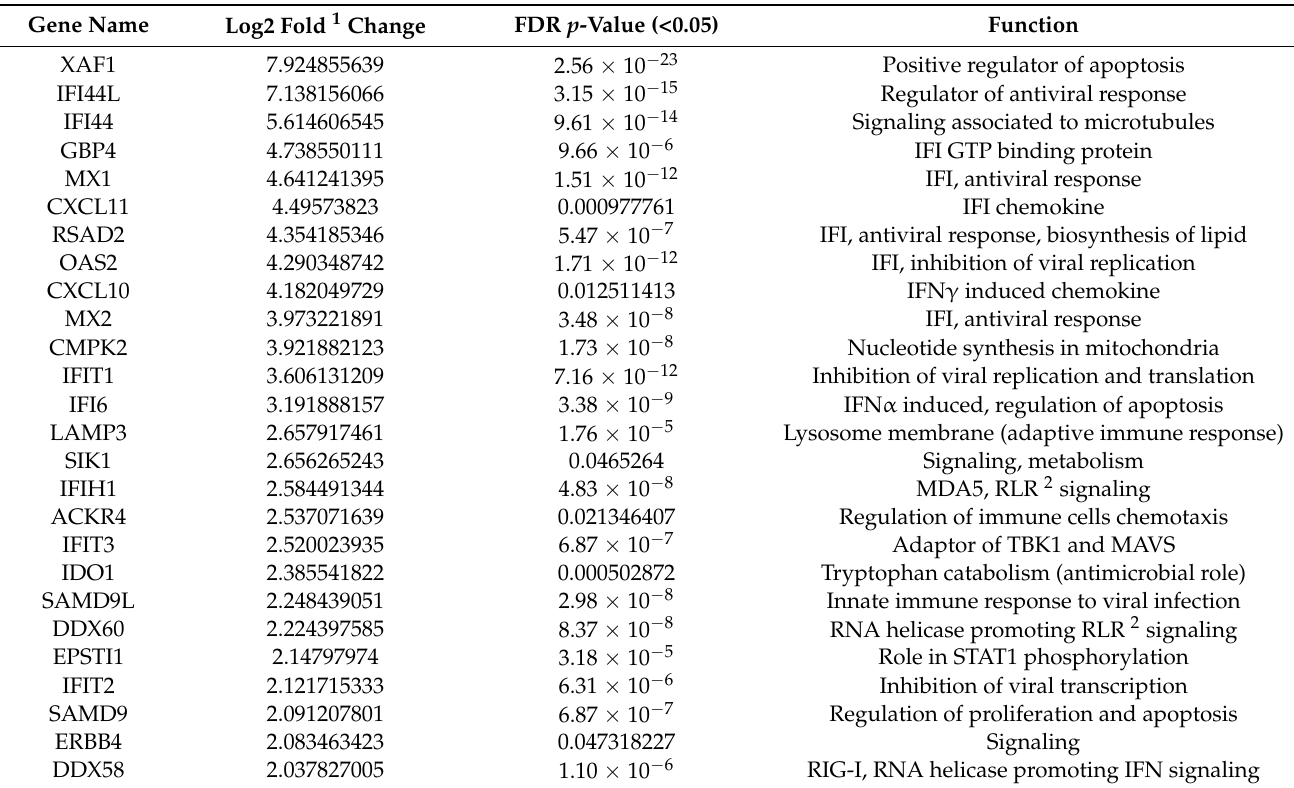
Table 1. Genes activated following PUUV Sotkamo wild-type infection of A549